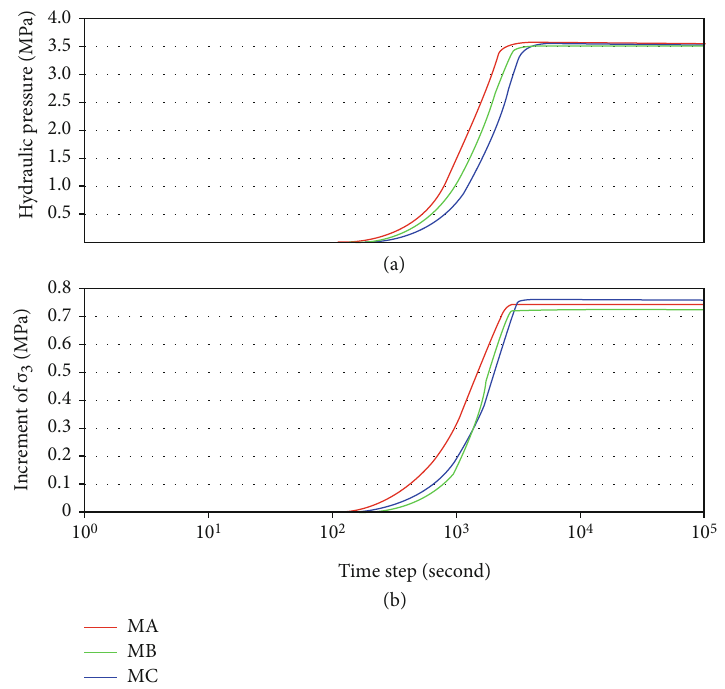
Figure 15: Evolutions of the hydraulic pressures and incremental tensile stresses.